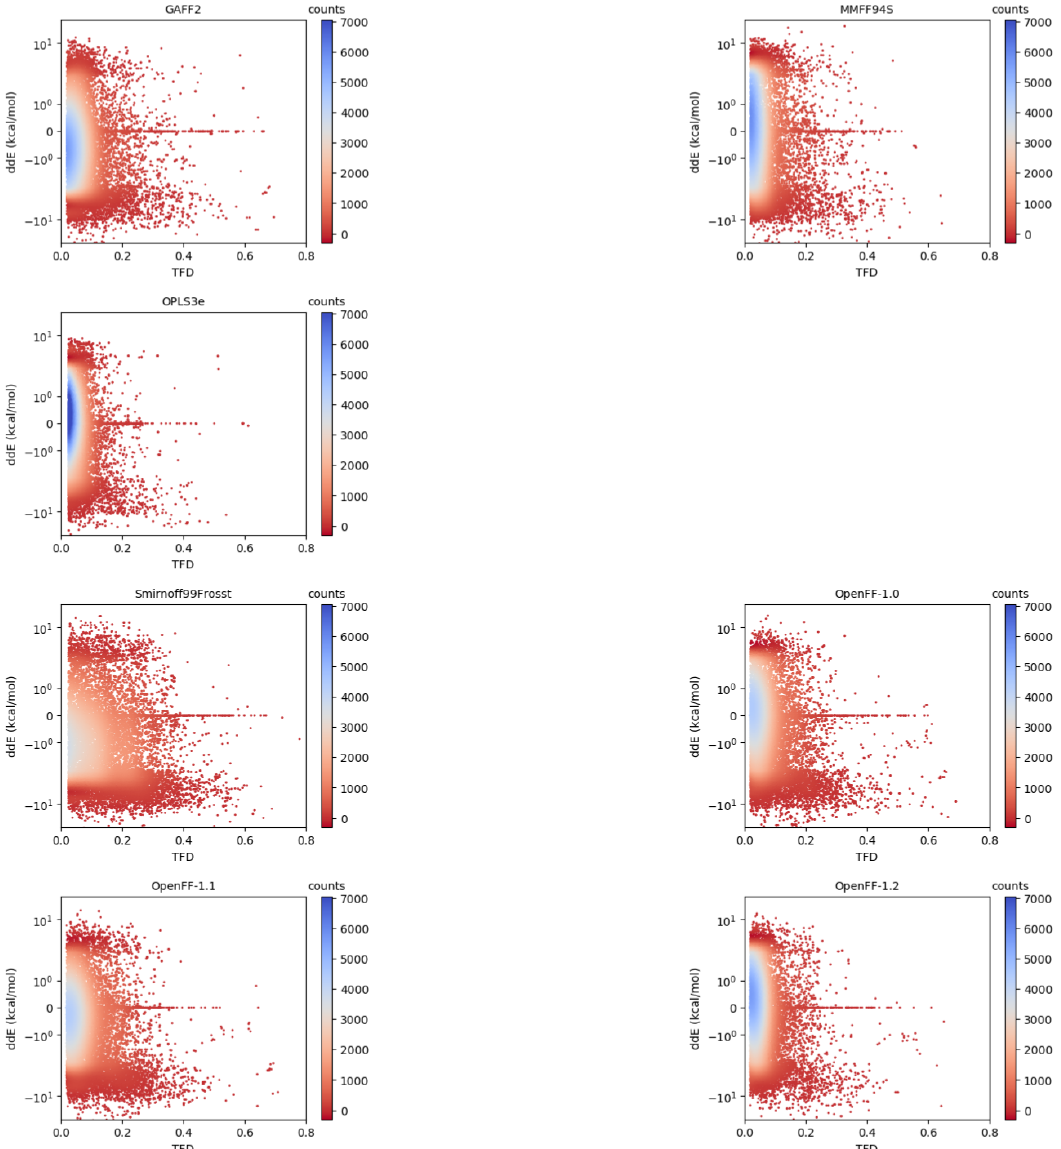
Figure 7. Scatter plots of relative conformer energies (ddE) versus TFD scores. The points are colored by the interpolated density of points in a certain area. Blue indicates region of high density, that is, high compactness of points in that area. A force field having better agreement in both relative energies and geometries with the QM reference would have more points around the origin (ddE = 0, TFD = 0), though it is presumably possible for a force field to improve along one axis without improving along the other. The vertical axis is represented on logarithmic scale; the same plots with linear scaling can be found in the Extended data , Figure S.7 93